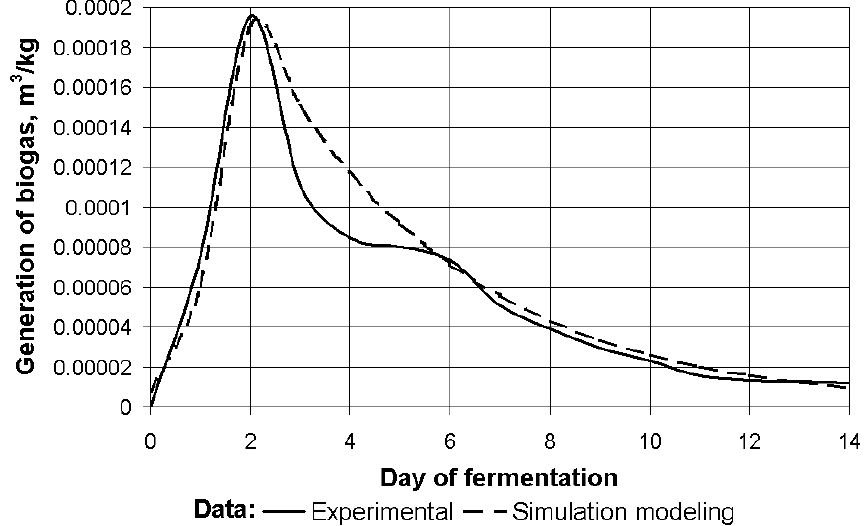
Figure 9. Results of comparison of simulation data with experimental data for cattle manure fermentation with the addition of 26.1% molasses vinasse at a fermentation temperature of 40 °C.